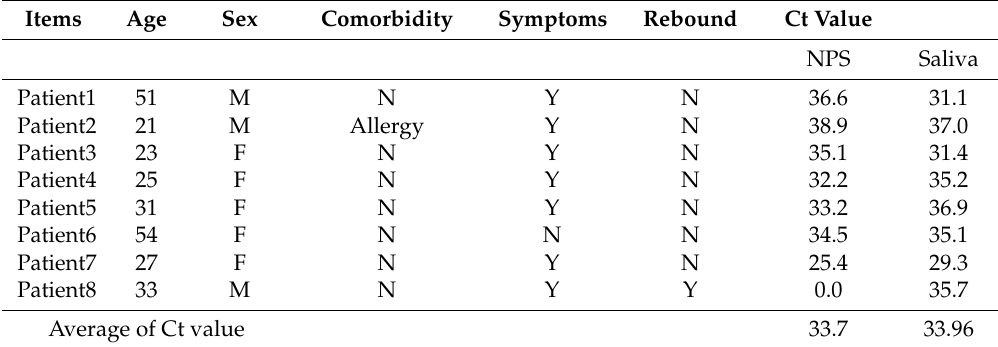
Table 3. Clinical characteristics and Ct value of patients with positive salivary RT-PCR result.